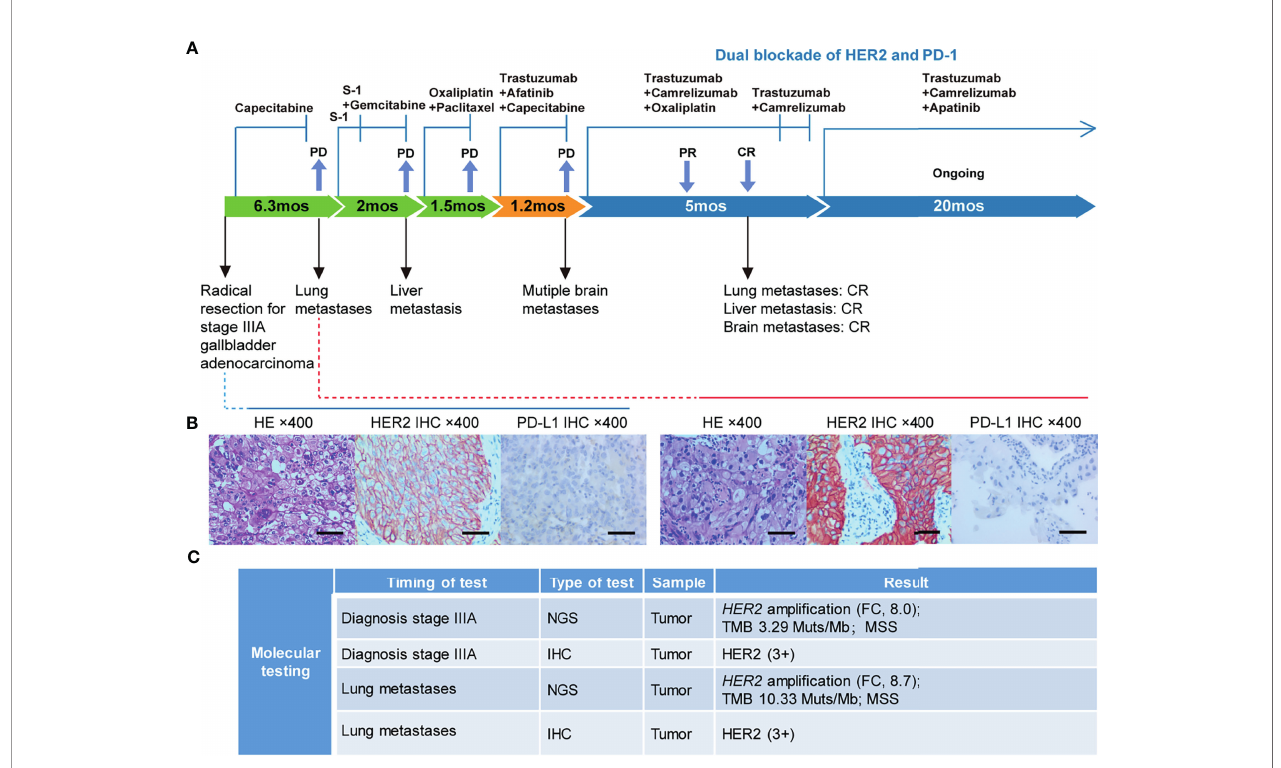
FIGURE 1 | Case summary. (A) Summary of disease course, treatment procedure, and key molecular fi ndings. PR, partial response; CR, complete response; PD, progressive disease; mo, months. (B) H&E, HER2, and PD-L1 staining of the primary tumor and lung metastasis. Scale bars: 25 µm. H&E: hematoxylin and eosin. (C) Detailed molecular alterations of the primary tumor and lung metastasis. FC, fold change; MSS, microsatellite stable; TMB, tumor mutational